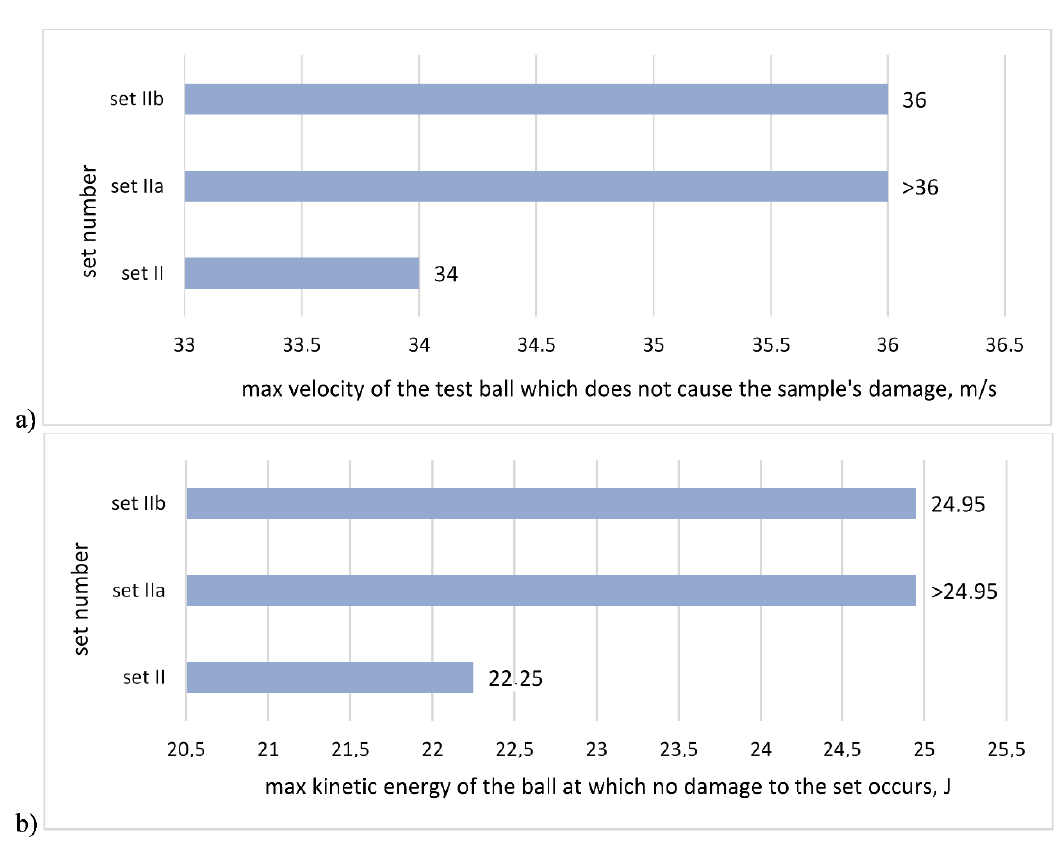
Figure 5. Sample after hail resistance test with a visible mechanical damage in the middle.